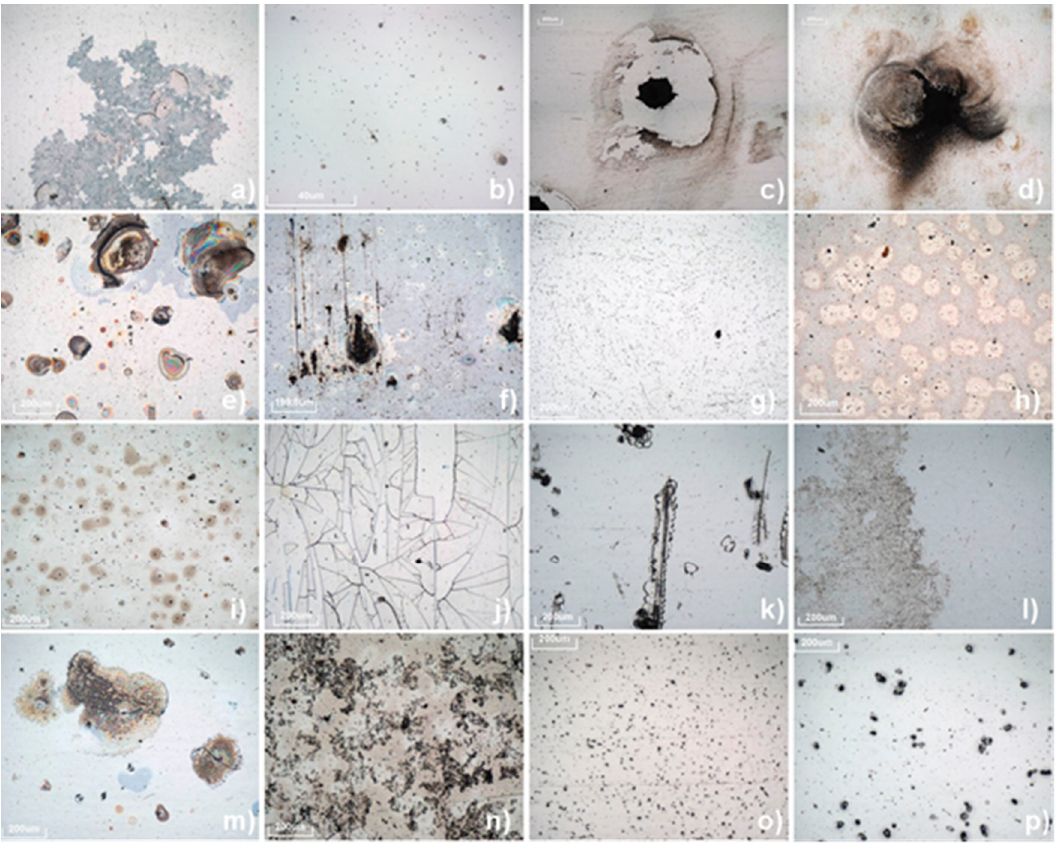
Figure 10. ( a ) PVD corrosion in material D after the NSS test (compare to outdoor results in Figure 3); ( b ) Micropitting in material A after the UV + Condensation test (compare to outdoor results in Figure 4); ( c ) Pitting corrosion in material G after the CASS test (compare to outdoor results in Figure 7); ( d ) Strong Pitting corrosion after the CASS test (detected in all materials); ( e ) Cracks and delamination in material A after the NSS test; ( f ) Cracks and delamination in material C after the NSS test; ( g ) Deposits on sample surface after the Damp Heat test (detected in all materials); ( h ) Layer changes in material C after the Damp Heat test; ( i ) Layer changes in material C after the UV + Condensation test; ( j ) Cracks in material F after the UV + Condensation test; ( k ) Scratches in material A after the Humidity freeze test; ( l ) Surface deposits on the surface of material A after the UV + Condensation test with sand (compare to outdoor results in Figure 6); ( m ) Deterioration in material B after the NSS + Sand test; ( n ) Non-removable sand deposits in material C after the Damp Heat + Sand tests; ( o ) Abrasion defects after sandstorm chamber test; ( p ) Abrasion defects after soil pipe test.